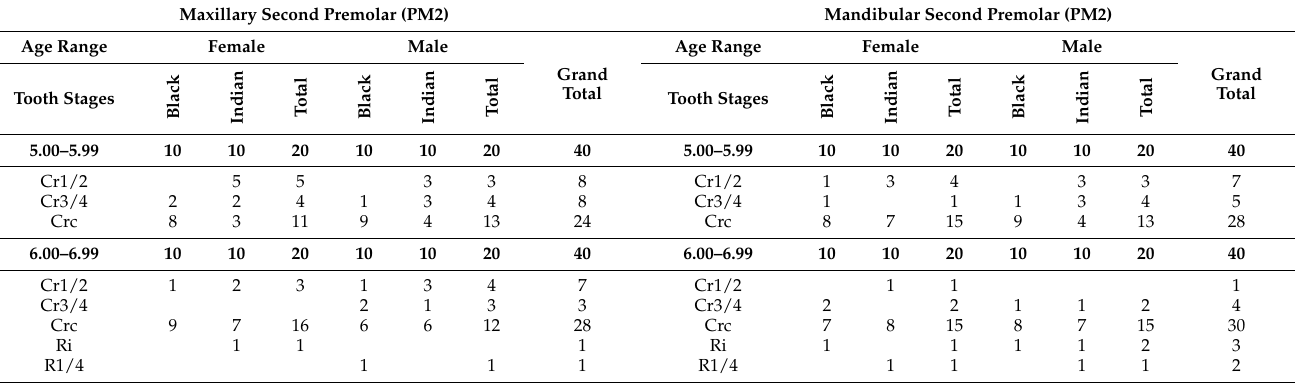
Table A5. Frequencies of the tooth development stages of the second premolar for the SA Black and Indian population